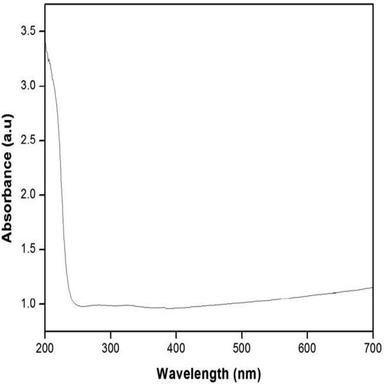
a) UV–Visible spectrum of Bi2Se3 nanostructures (co-precipitation method with capping). b) Tauc plot of Bi2Se3 nanostructures (co-precipitation method with capping).